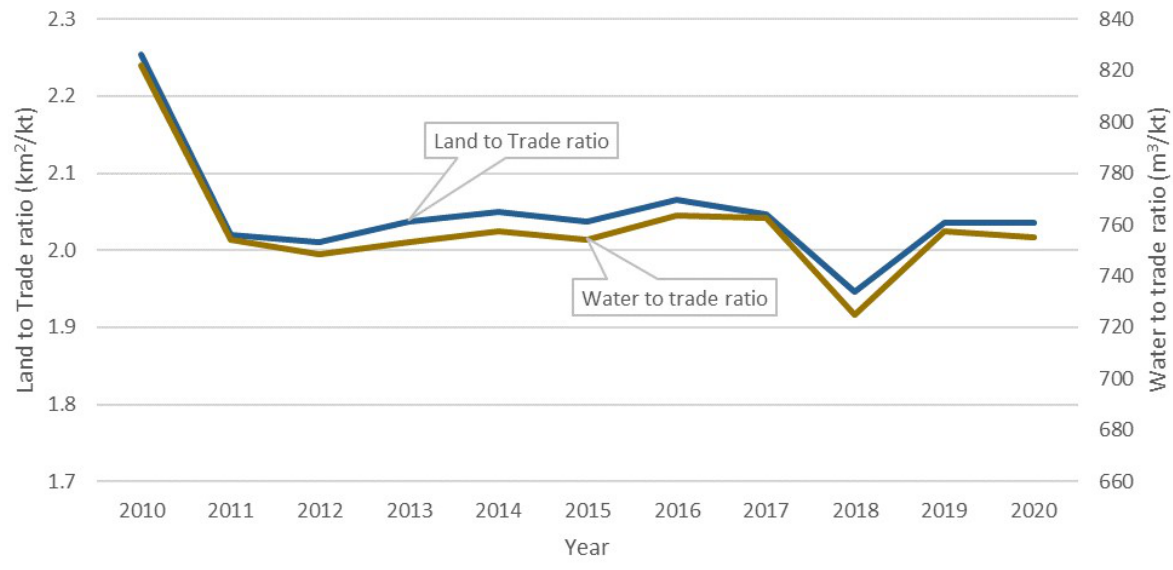
Figure 16. Ratios of virtual quantities with annual net trade shows there is a trend of crops that contain lower virtual quantities.